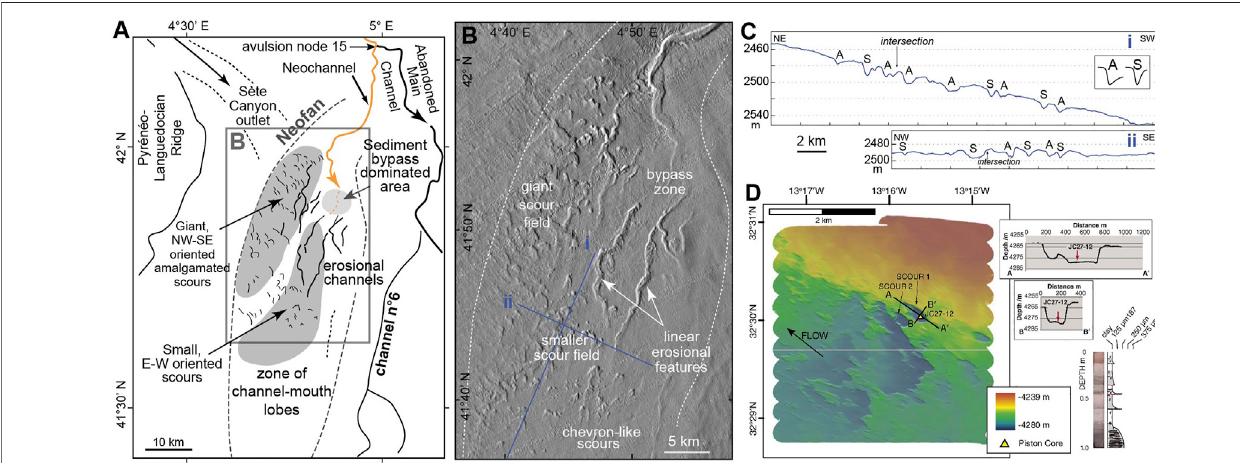
FIGURE 3 | Erosional CLTZ sea fl oor features. Schematic interpretive map (A) , shaded multibeam bathymetry (B) , and sea fl oor relief pro fi les (C) of the Rhône neofan CLTZ (modi fi ed from Droz et al., 2020, courtesy of L. Droz). (C) Sea fl oor pro fi les from the Rhône neofan CLTZ (modi fi ed from Droz et al., 2020, courtesy of L. Droz). Scours are designated as asymmetrical (A) and symmetrical (S). (D) Autosub6000 high-resolution bathymetry, sea fl oor pro fi les, and piston core from long-lived mega-scours from the Agadir CLTZ (modi fi ed from Macdonald et al.,